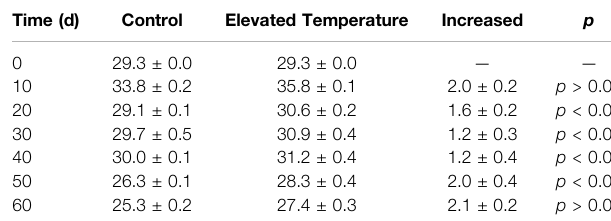
TABLE 1 | Water temperature ( ° C).